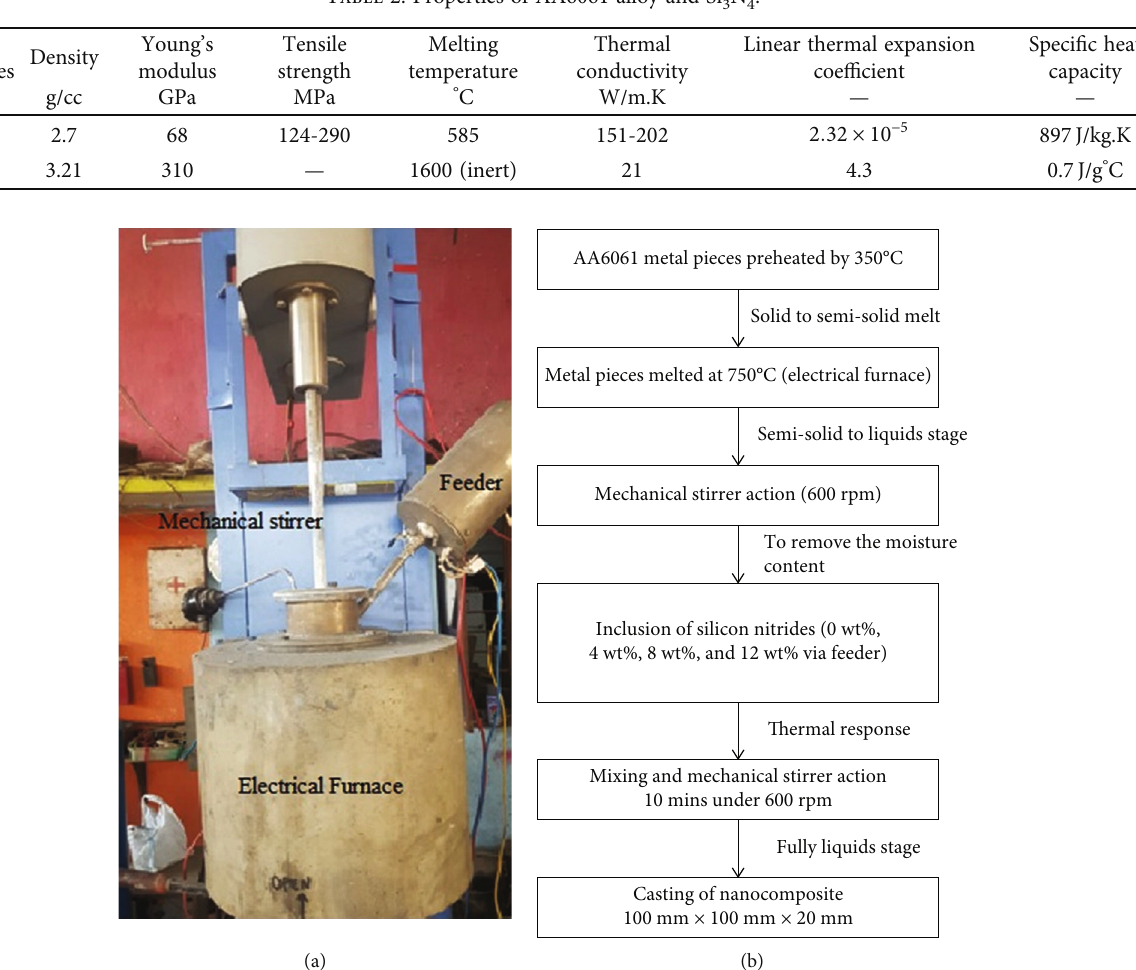
Table 2: Properties of AA6061 alloy and Si